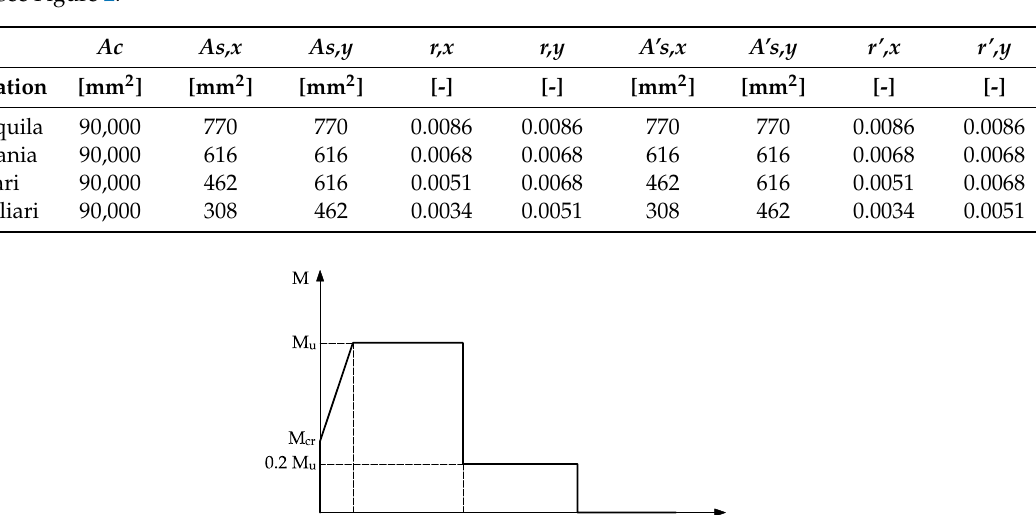
Table 4. Reinforcements details for columns in each structure, Ac represents the concrete area, As the tensile reinforcement, A’s the compressive reinforcement, r is the reinforcement ratio ( r = As / Ac ) while the letter x or y denotes the reinforcements for the bending moment around x axis or y axis respectively, see Figure 2.